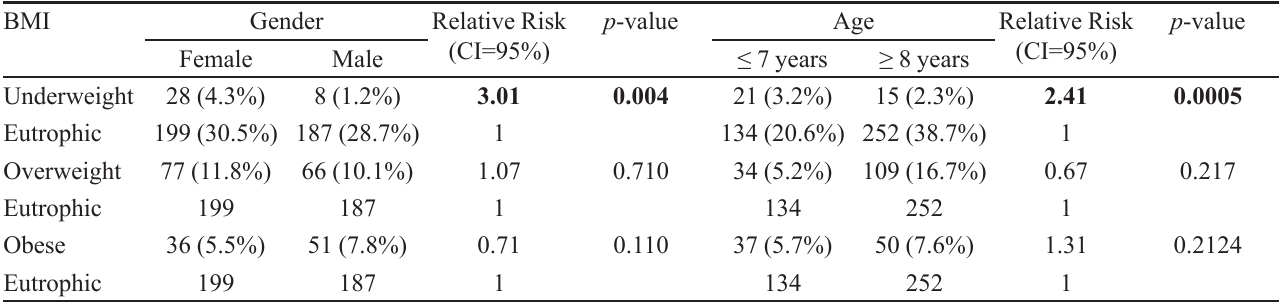
TABLE II - Distribution of number and percentage of school children according to gender and age and values associated to BMI indices. Maringá - PR, 2005